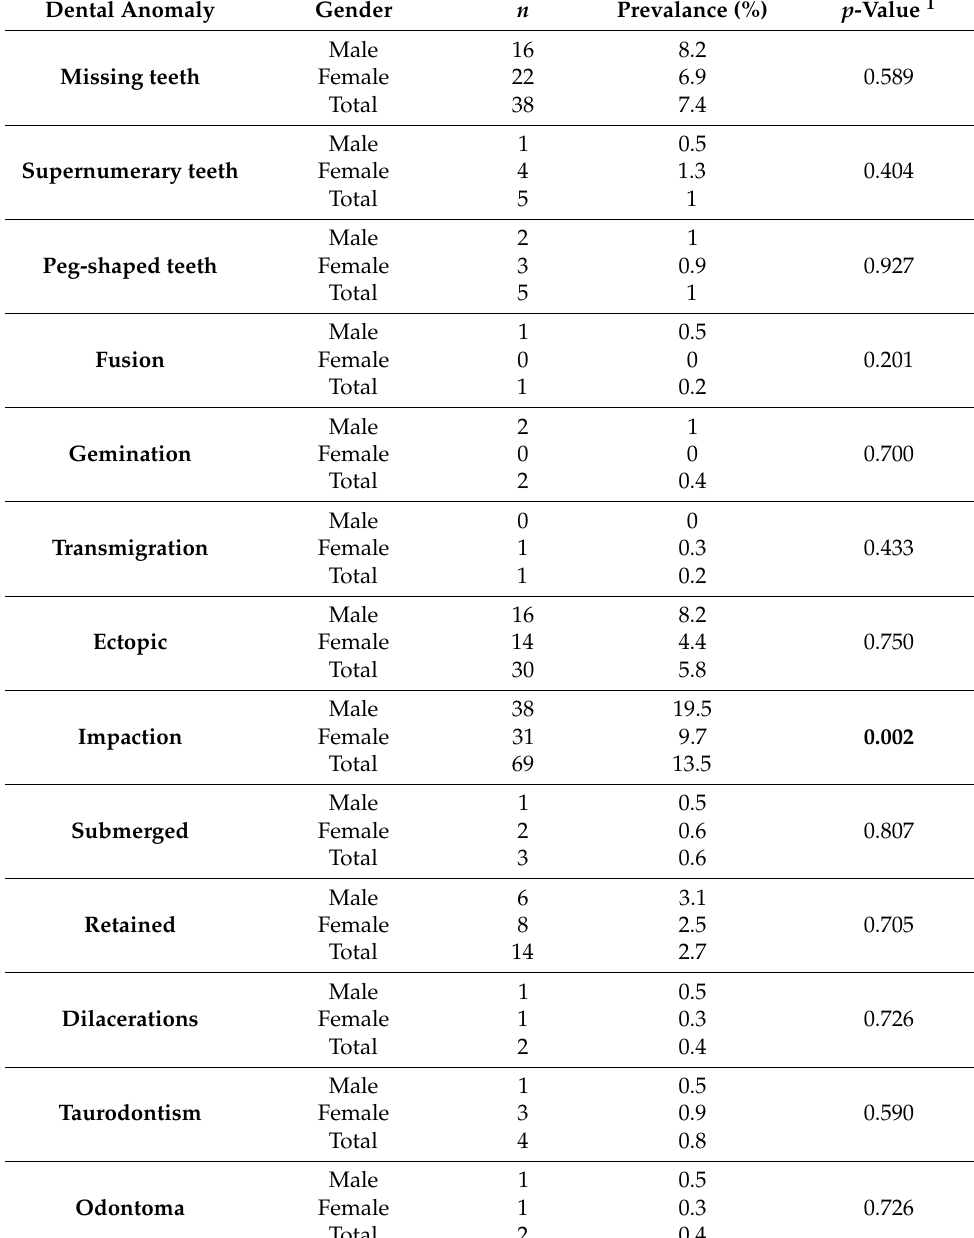
Table 2. Prevalence of dental anomalies by